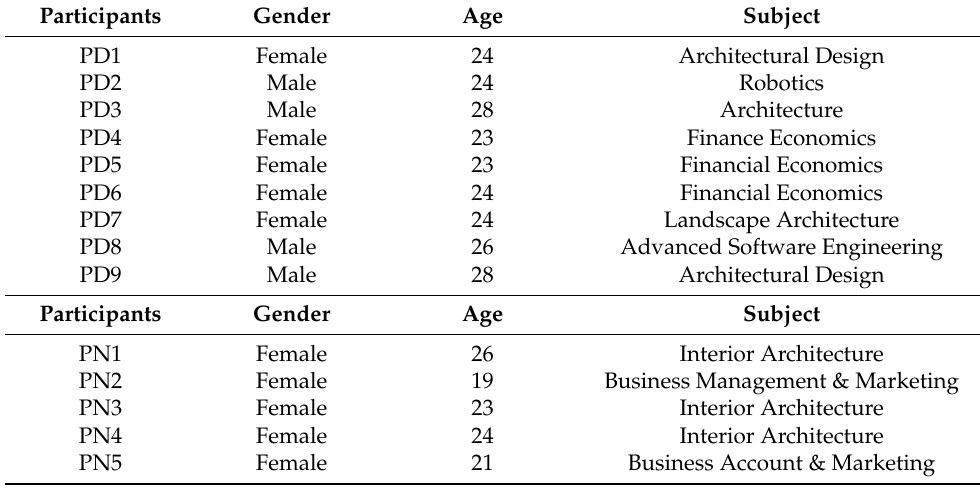
Table 4. Participant information of focus groups at Diamond (PD1-9) and at Newton